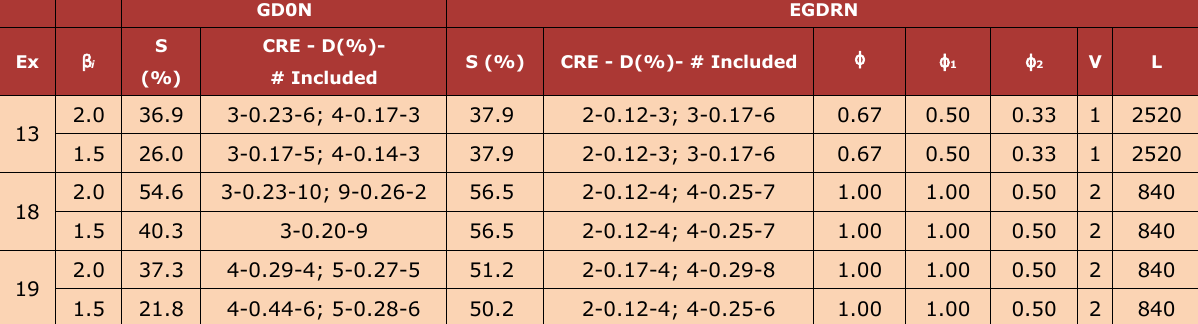
Table 4. Numerical Examples with two CREs and retailers’